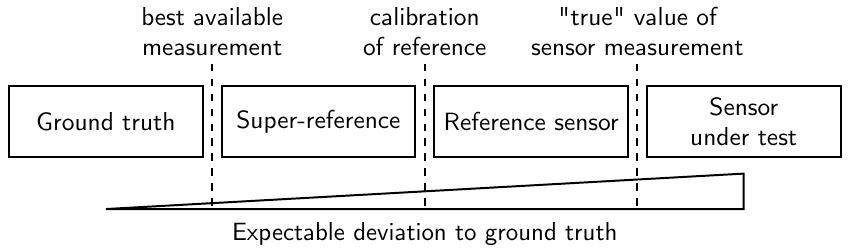
Figure 1. Relationship between GT, super-reference, reference sensor, and sensor under